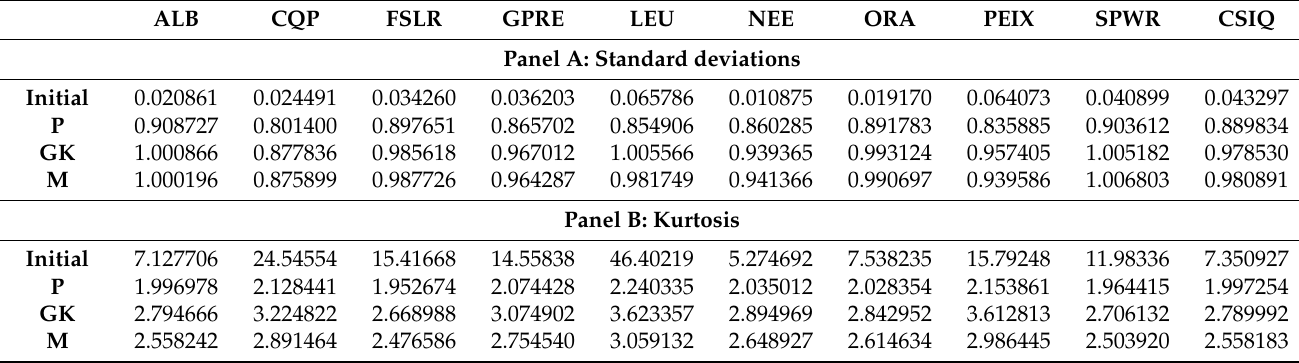
Table 5. Standard deviations and kurtosis of the initial and standardized returns.